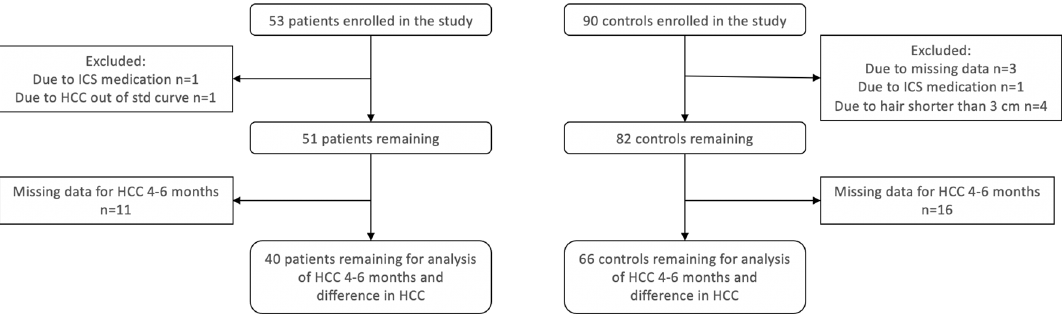
Figure 1. Flowchart over inclusion and exclusion of patients and